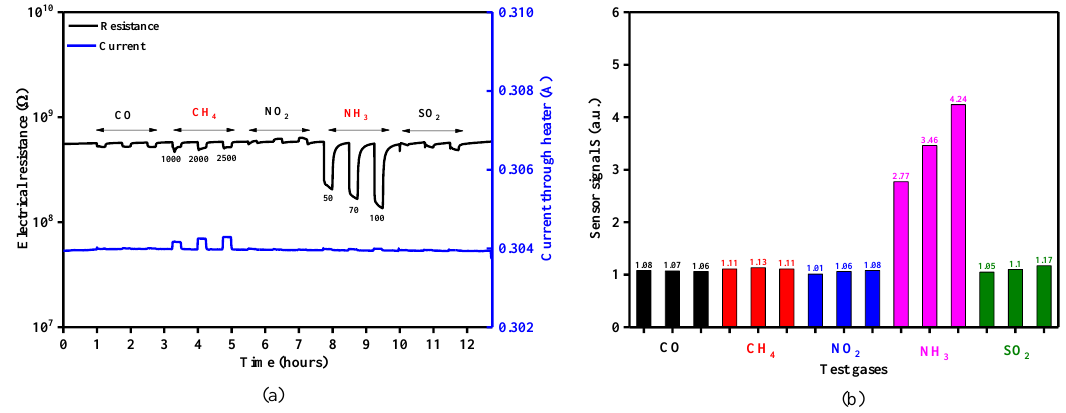
Figure 12. ( a ) Electrical resistance and current response of a 50 nm TiO 2 coated gas sensor substrates exposed to different concentrations of CO, CH 4 , NO 2 , NH 3 and SO 2 under 0% RH at 350 °C and ( b ) the associated sensor signals responses.